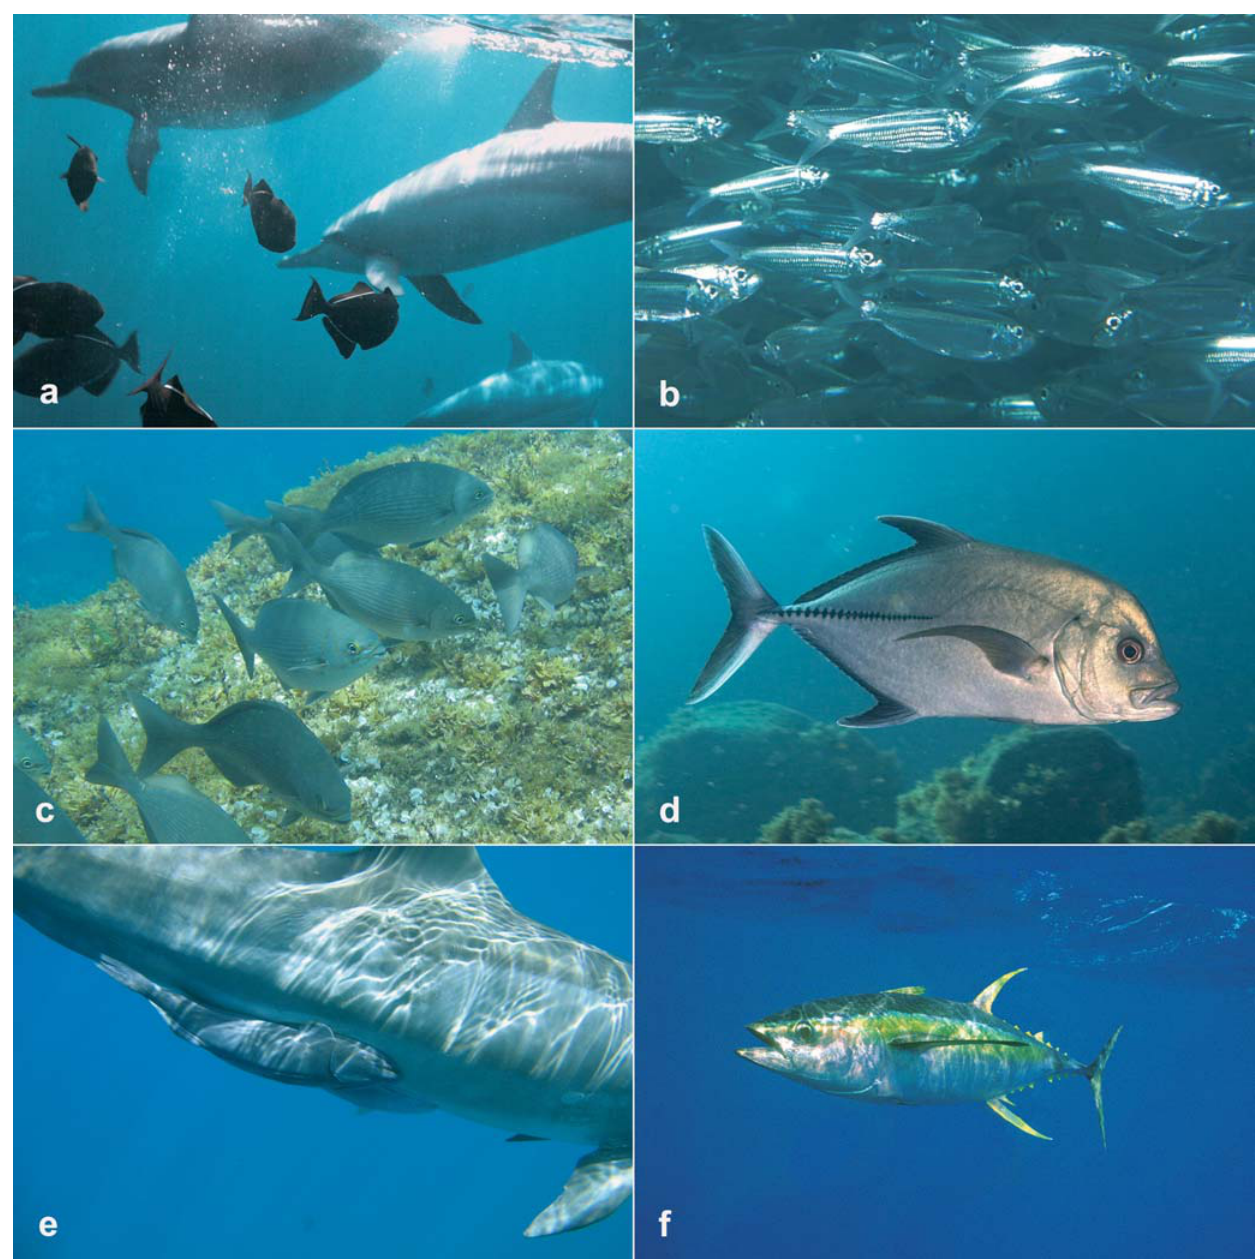
Fig. 1. Six selected fish species recorded in association with spinner dolphins ( Stenella longirostris ) at Fernando de Noronha Archipelago. Black durgon ( Melichthys niger ), a particle-forager and browser that feeds on dolphin wastes habitually in the Dolphins’ Bay (a). Photo by I. Sazima. Scaled sardine ( Harengula jaguana ), a particle-forager that feeds on dolphin wastes occasionally while the dolphins cruise close to sandy beaches (b). Photo by C. Sazima. Bermuda chub ( Kyphosus sectatrix ), a browser and particle-forager that feeds on dolphin wastes occasionally in the Dolphins’ Bay (c). Photo by C. Sazima. Black jack ( Caranx lugubris ), a roving carnivore that feeds on dolphin wastes occasionally in the Dolphins’ Bay (d). Photo by J. P. Krajewski. Whalesucker ( Remora australis ), a hitch-hiker on cetaceans that forages on spinner dolphin wastes and cleans them of parasites and dead tissue (e). Photo by J. M. Silva Jr. Yellowfin tuna ( Thunnus albacares ), a roving carnivore that joins spinner dolphins while the latter forage for schooling fish and squids in their hunting grounds around the archipelago (f). Photo by G. Marcovaldi (Banco de Imagens